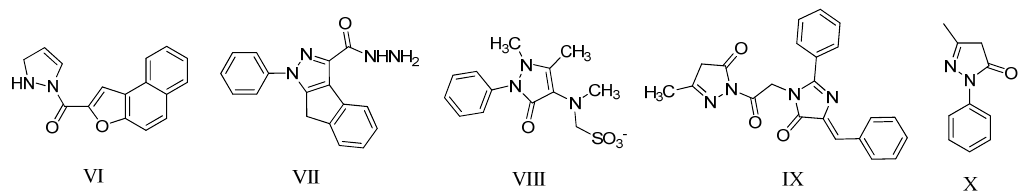
Figure 2. Examples of biologically active pyrazolone